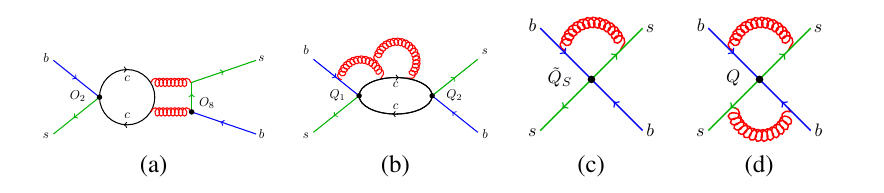
¯ bs matching calculation. !